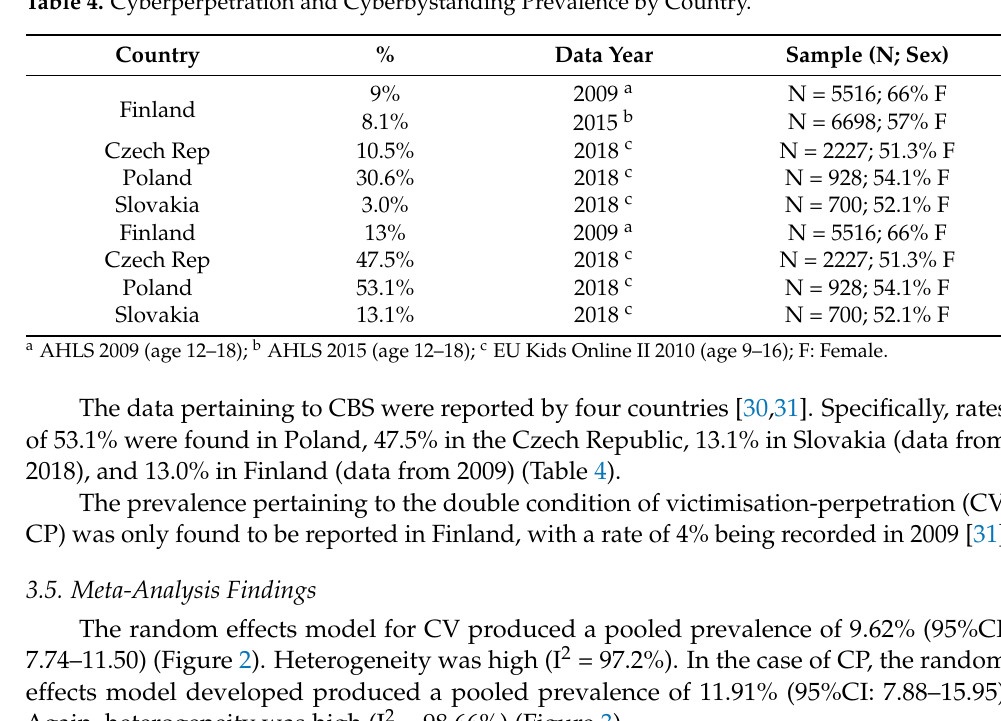
Table 4. Cyberperpetration and Cyberbystanding Prevalence by Country.